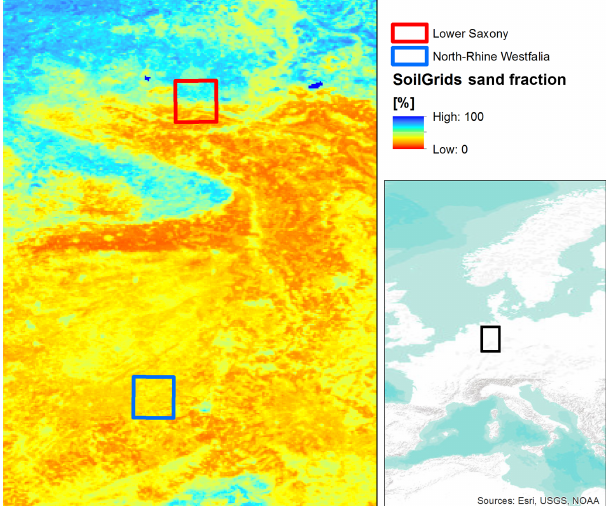
Figure 2. Location of the 0.25 ◦ test pixels in Germany, and their sand fraction based on